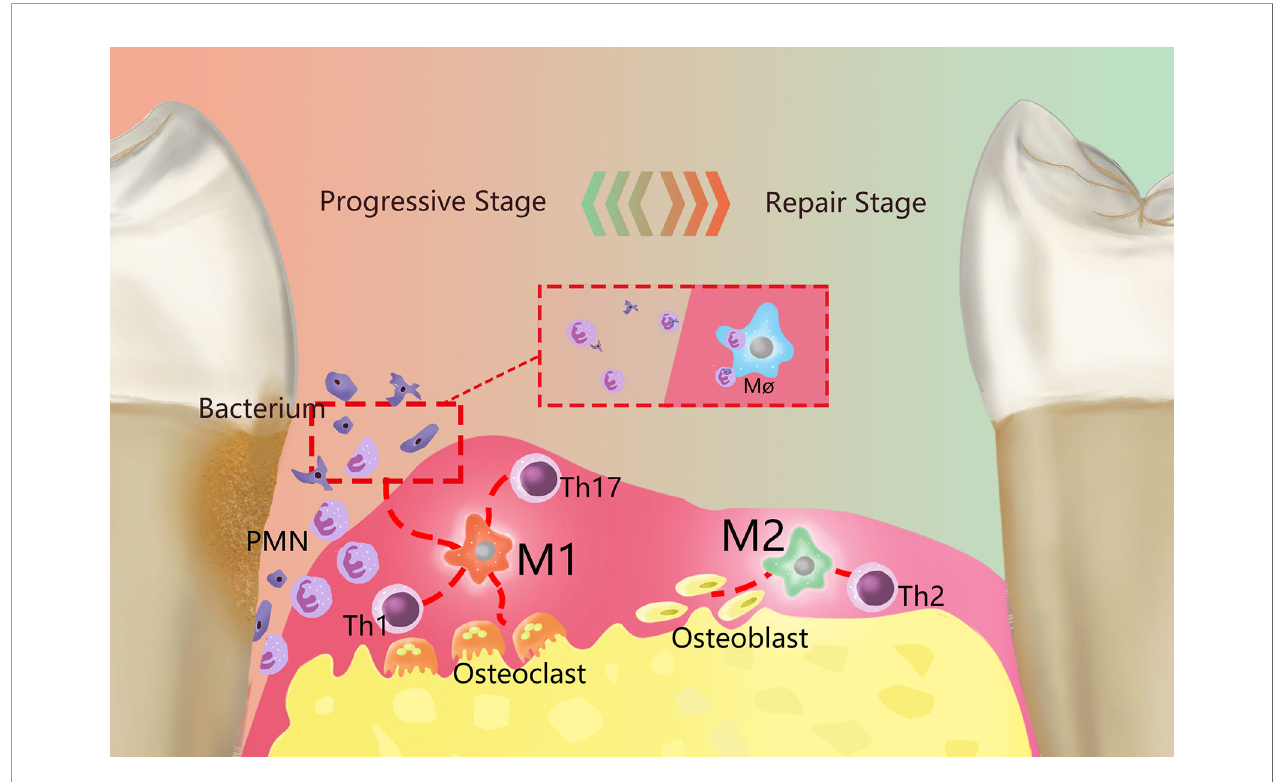
FIGURE 1 | Overview of the role of polarized macrophages in the occurrence and development of PD. Resident macrophages in PD generate two primary phenotypes, M1 and M2, through polarization, which dominate the developmental and regression stages of in fl ammation, respectively. M1 is primarily proin fl ammatory and produce a series of proin fl ammatory factors and work together with Th1 cells, Th2 cells and other cells. Primarily by working with Th1-type immune cells, M1 can remove periodontal pathogenic microorganisms by recruiting PMNs. Meanwhile, M1 activates osteoclasts and causes absorption of the alveolar ridge. M2 primarily plays an anti-in fl ammatory role and are mainly immune to Th2 cells. M2 terminates in fl ammatory progression by promoting the apoptosis of M1and PMNs, performed tissue repair through various anti-in fl ammatory factors, and can activate osteoblasts to restore bone